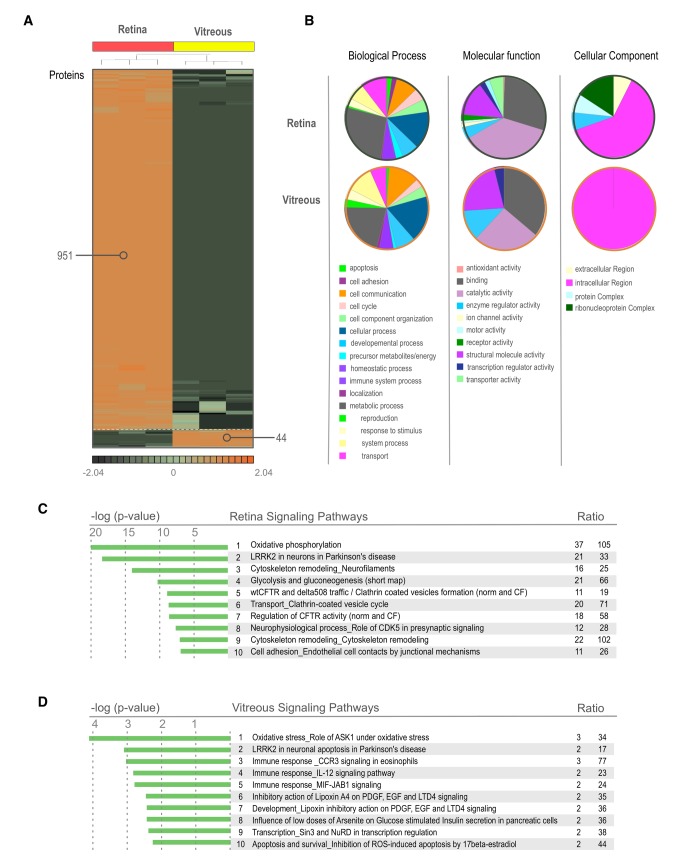
Differentially expressed proteins in the Retina and Vitreous.
A. Heatmap showing the differentially expressed proteins of the mouse vitreous and retina (p < 0.05). There is a large population of proteins that are overexpressed in the retina in comparison to the vitreous. Proteins that are found in this heatmap provide an excellent reference for potential disease markers. Proteins that change their expression in these tissues could be used as potential biomarkers in the future. B. Gene Ontology distribution of proteins differentially expressed in the mouse vitreous and retina. Proteins are grouped into sub-categories of (A.) biological processes, (B.) cellular component, and (C.) molecular processes. C. List of pathways most highly represented in the mouse retina and vitreous tissues. These pathways were identified using GeneGO analysis software.